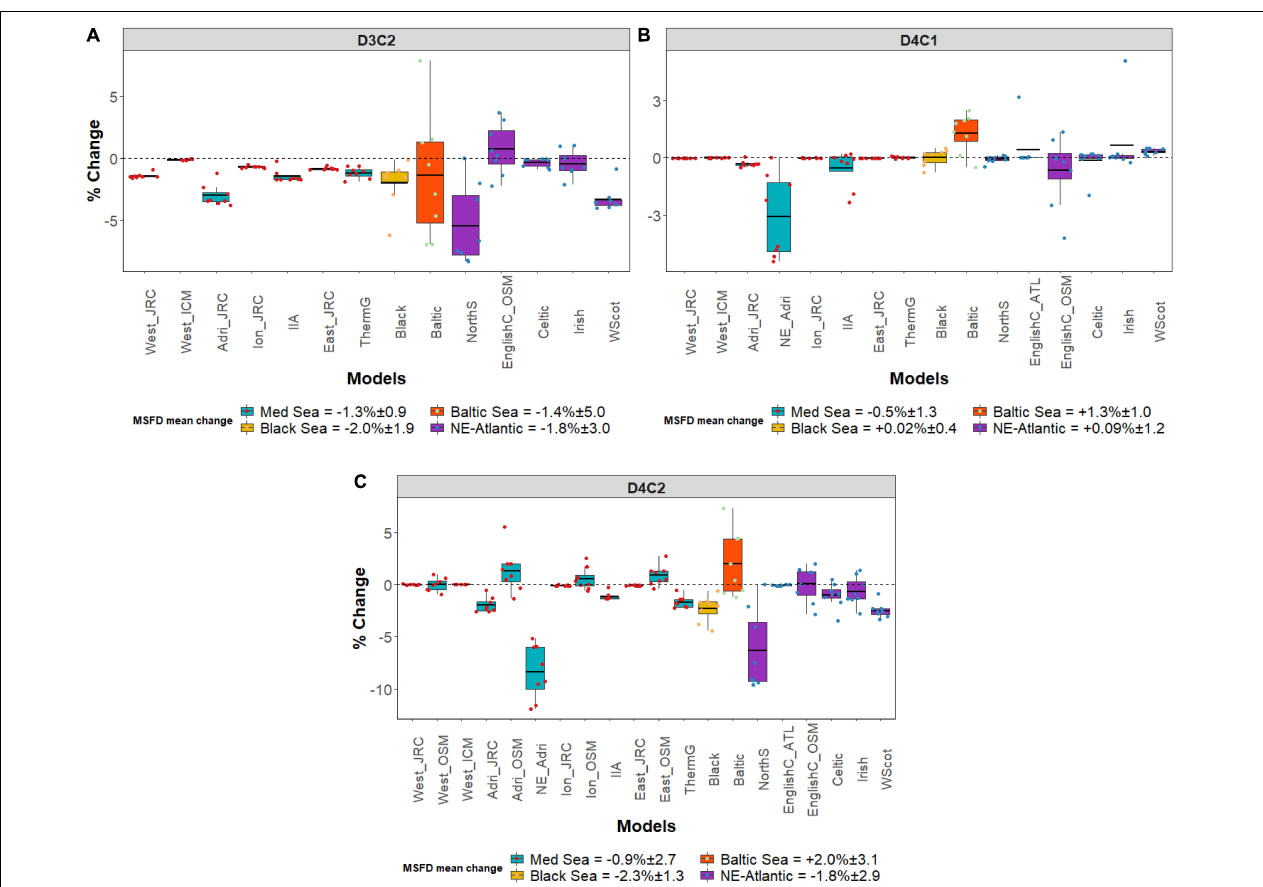
FIGURE 2 | Box plots representing the mean change (%) and standard deviation between MTFR and REF scenario for the selected MSFD criteria: (A) Spawning stock biomass (SSB) of a commercially important small pelagic fish (D3C2); (B) Species diversity index (D4C1) and (C) Small pelagic fish biomass (D4C2) for every MSFD region/sub-region and smaller areas within an MSFD region/sub-region (the acronyms correspond to those given in Table 1 ). Yearly modeled data points are plotted as colored circles. D3C2 is not displayed for Med-Osmose and NE_Adri as not available, same for D4C1 and